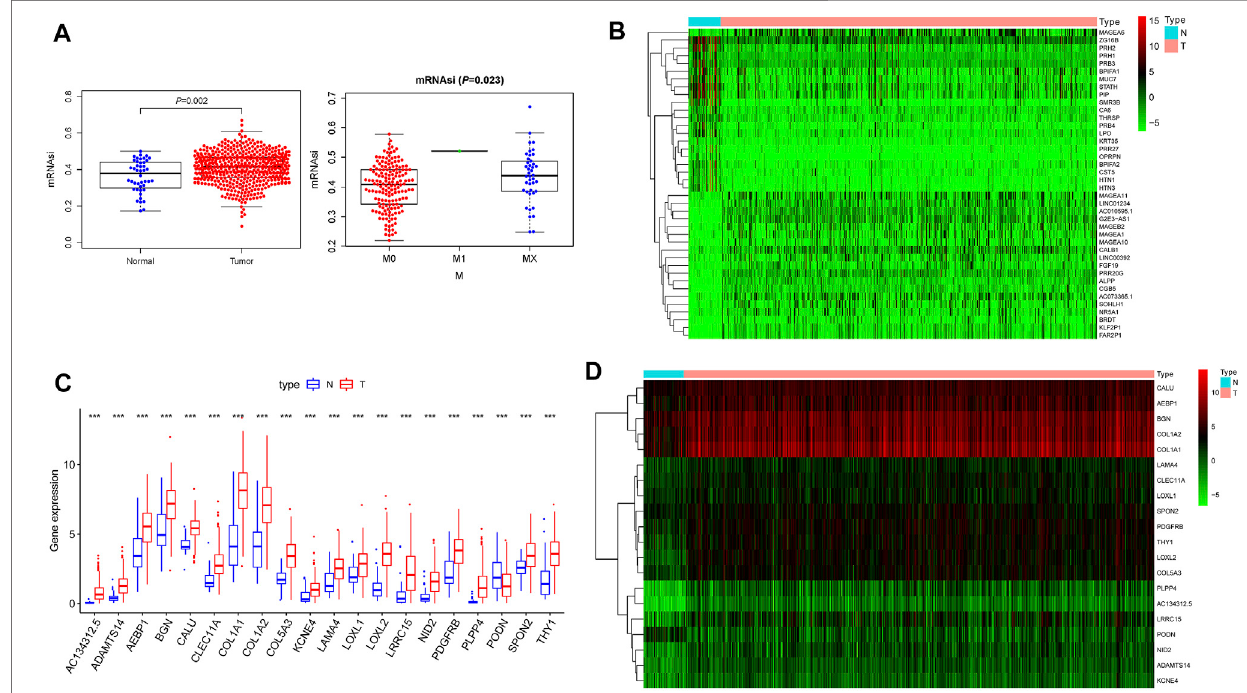
FIGURE 1 | The characteristics of the mRNAsi. (A) . The connection of clinical factors and mRNAsi expressions and our results demonstrated that mRNAsi correlated signi fi cantly with the patient M-classi fi cation; (B) . The heatmap of the top 20 upregulated and downregulated differentially expressed genes of 4,732 DEGs between the HNSCC and normal samples; (C) . The difference expression transcriptional levels of these 20 key genes in cancers and normal samples; we found all key genes to have signi fi cantly higher expressions in HNSCC tissues; (D) . The heatmap of 20 key genes in the brown